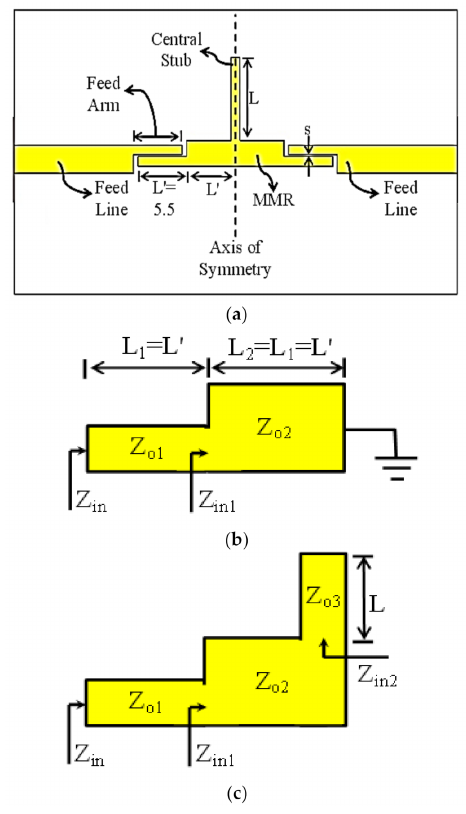
Figure 2. The structure of the proposed Stub Loaded Multiple Mode Resonator (SL-MMR): ( a ) the entire SL-MMR; ( b ) odd mode; and ( c ) even mode (all dimensions are in